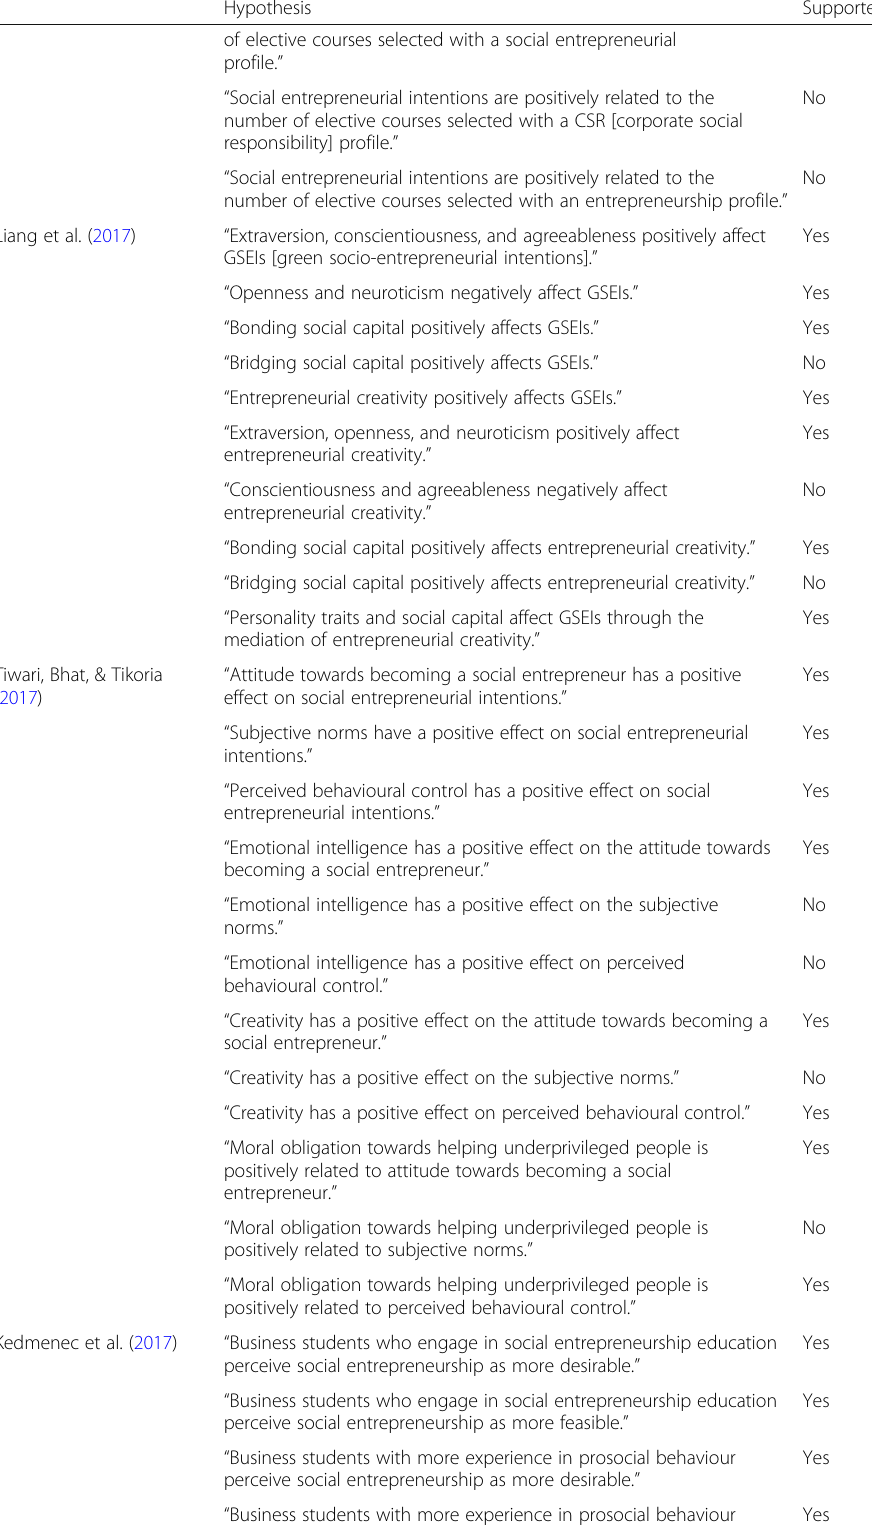
Table 2 Tabulated synthesis of results across different studies